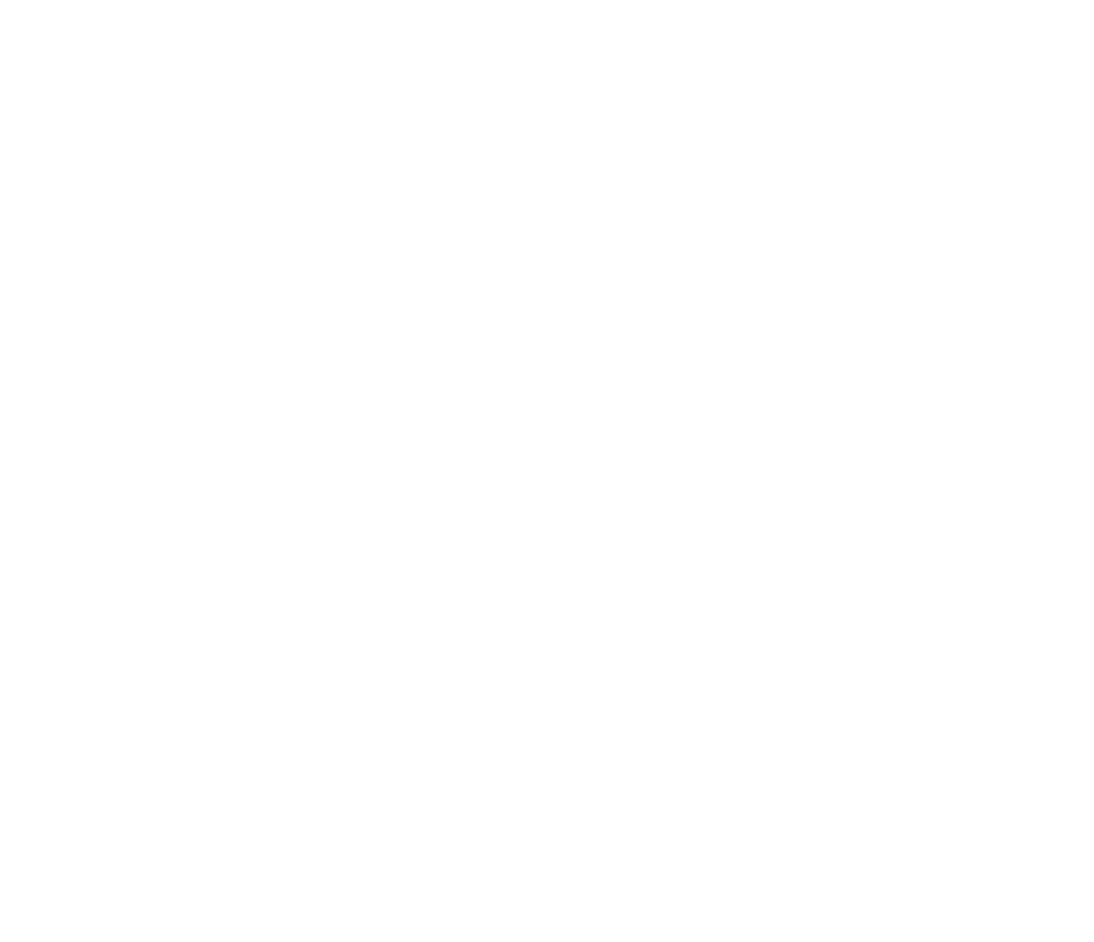
Frontiers in Climate |